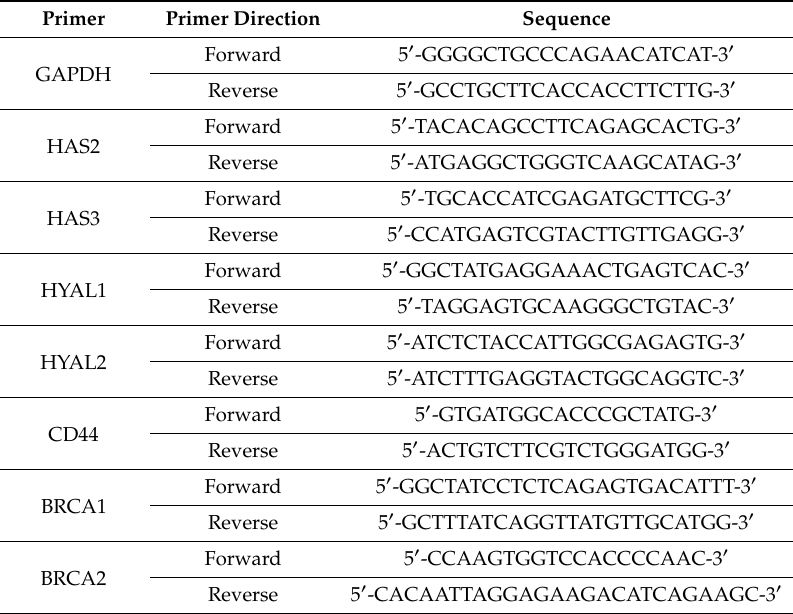
Table 2. List of primers used in this